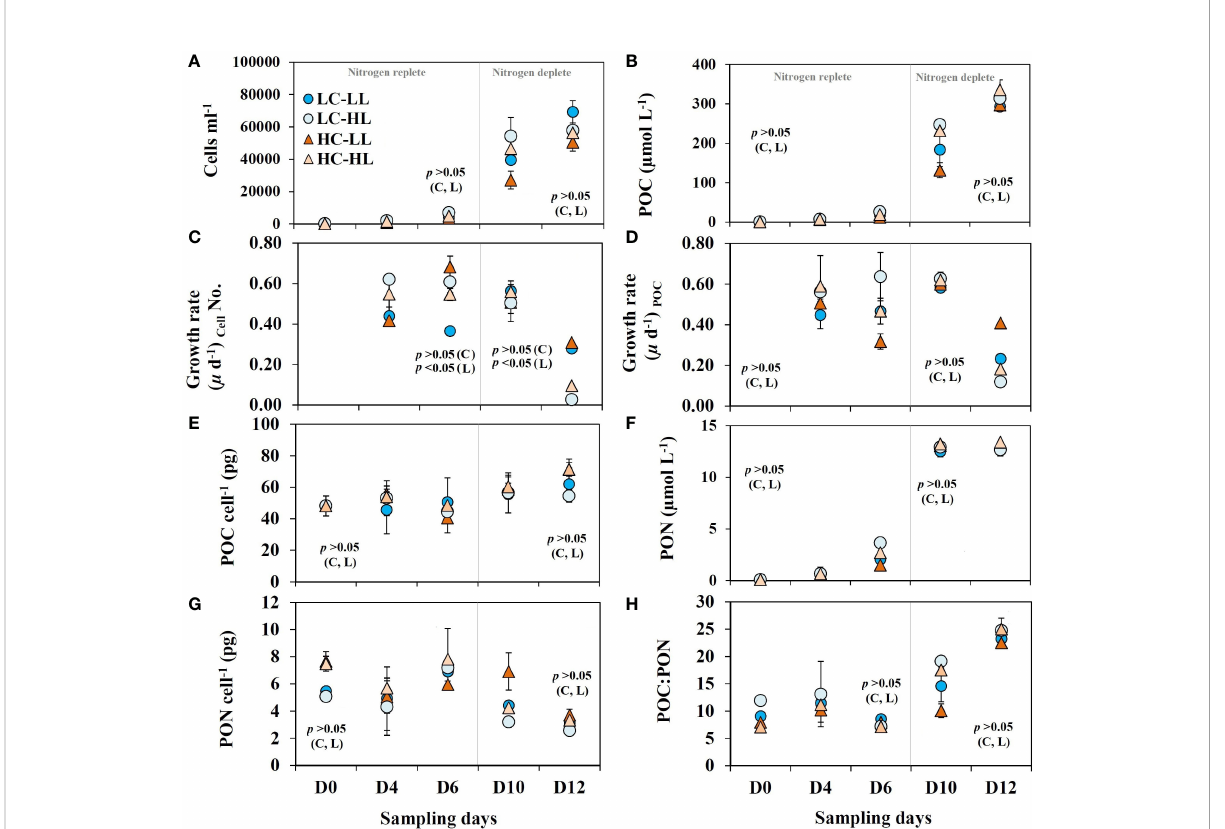
FIGURE 2 Growth dynamics of C . gelidus over the experimental period (total 12 days, D 0 – D 12 ) under two different light conditions [low light (LL) = 50 µmol m -2 s -1 , high light (HL) =100 µmol m -2 s -1 ] and CO 2 levels [low CO 2 (LC) ≈ 240 µatm and high CO 2 (HC) ≈ 900 µatm levels]. (A) cell density; (B) particulate organic carbon (POC) contents; growth rates calculated based on (C) cell number and (D) POC contents; (E) POC contents per cell; (F) particulate organic nitrogen (PON); (G) PON contents per cell; (H) the ratio between POC and PON (C:N) (n =3; ± SD). The level of signi fi cance ( p -values) related to CO 2 and light levels are shown as C and L, respectively. The gray line demarcates the nitrogen replete and deplete